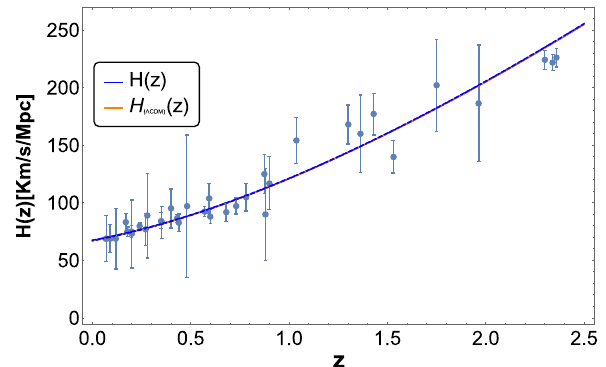
Fig. 10 We show the evolution of the Hubble rate H ( z ) as a function of the redshift z , for the values of parameters s = − 0 . 8, σ = 17 and λ = 0 . 01, and the same initial conditions used in Fig. 1, along with the evolution of the Hubble rate H Λ CDM ( z ) of the Λ CDM model and the Hubble data from Refs. [132,133]. We have used the current value of the Hubble rate H 0 = 67 . 4 km/(Mpc s) from Planck 2018